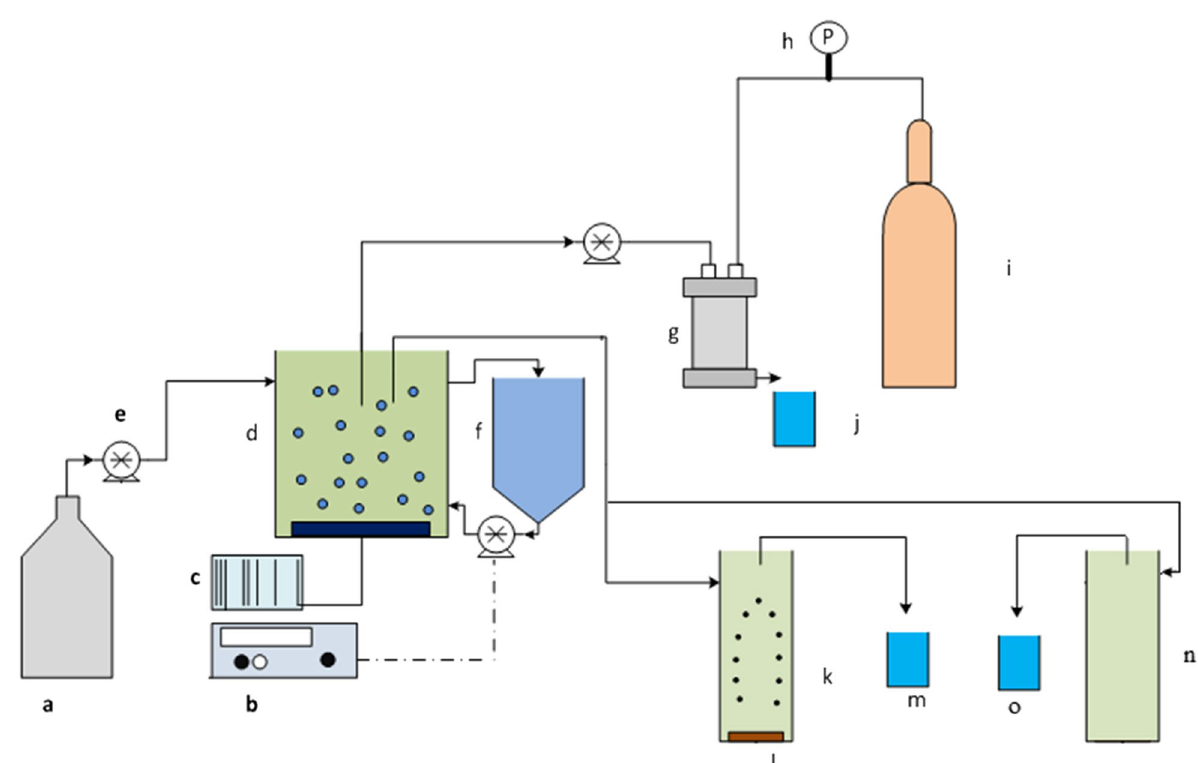
Fig. 1 Experimental setup used in this study. a Feed tank, b timer, c air pump, d bioreactor, e peristaltic pump, f settling tank, g filtra- tion cell, h pressure gauge, i nitrogen cylinder, j permeate reservoir,